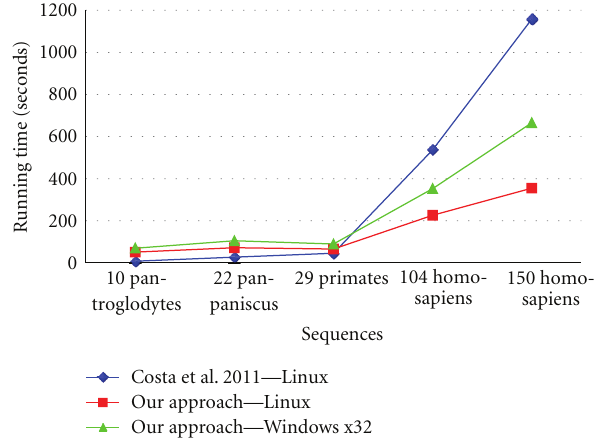
Figure 1: Di ff erences between running times of Costa et al. 2011 [8] approach and our suggested methodology.